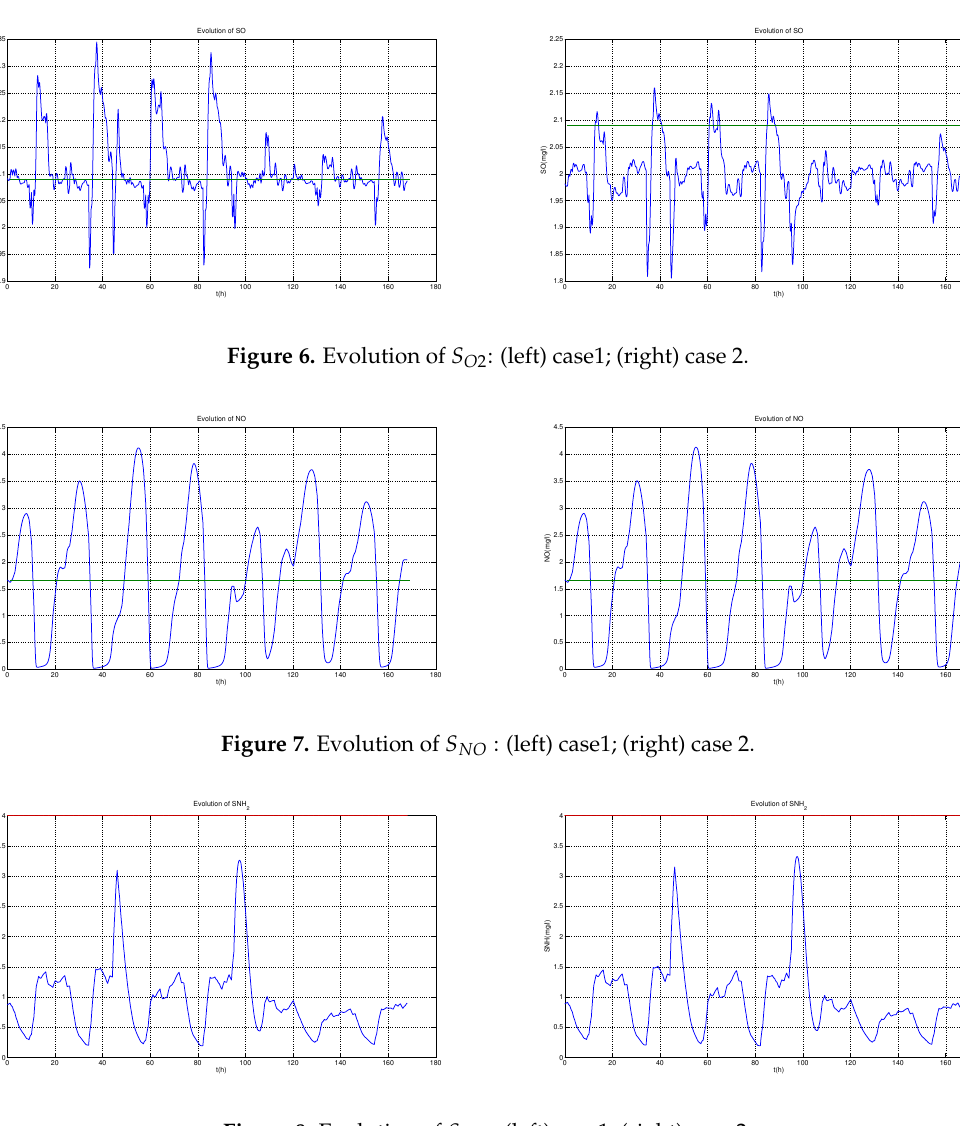
Figure 8. Evolution of S NH : (left) case1; (right) case